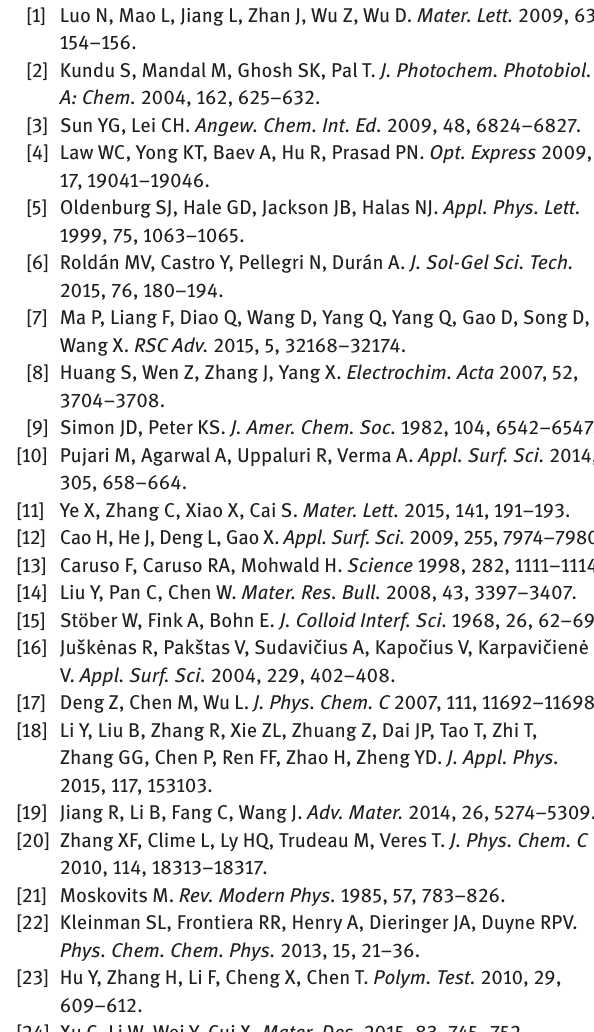
Figure 6: SERS spectra of DTNB. (a) with pure SiO SiO /Ag composite 2